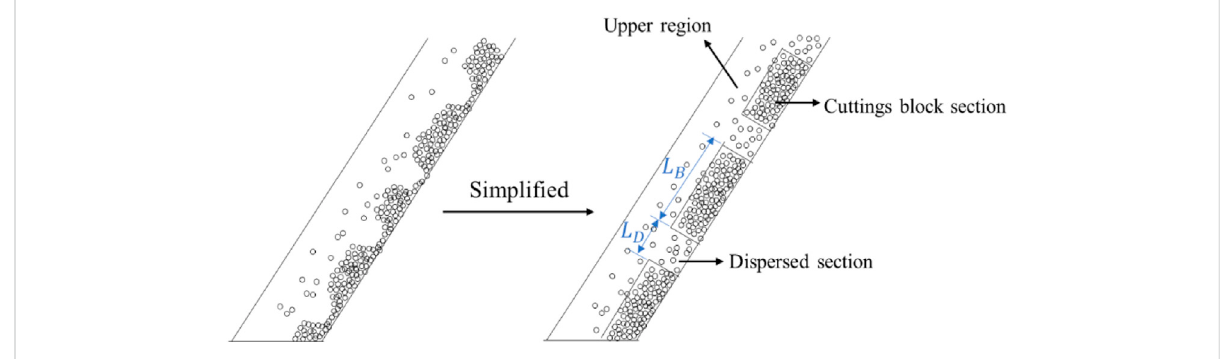
FIGURE 6 Simpli fi ed segment